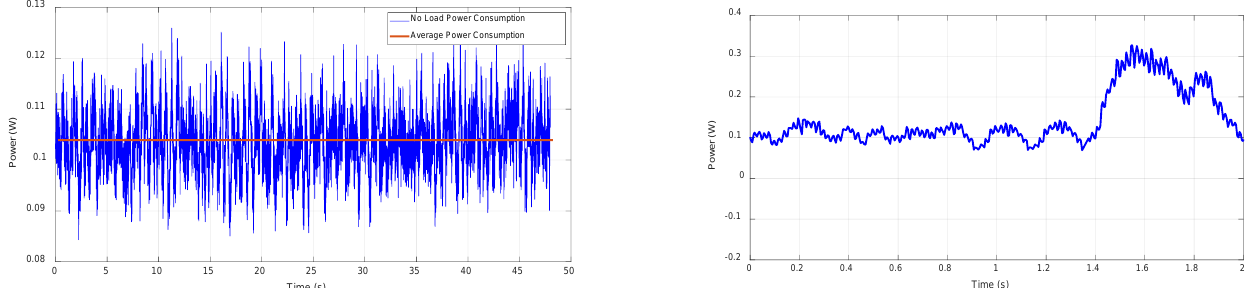
Figure 17. Power consumption when motor rotating at w = 30 rpm with no load ( left ), and total power consumption by the motor when moving system m = 0.315 kg, r = 0.15 m, w = 30 rpm ( right ).